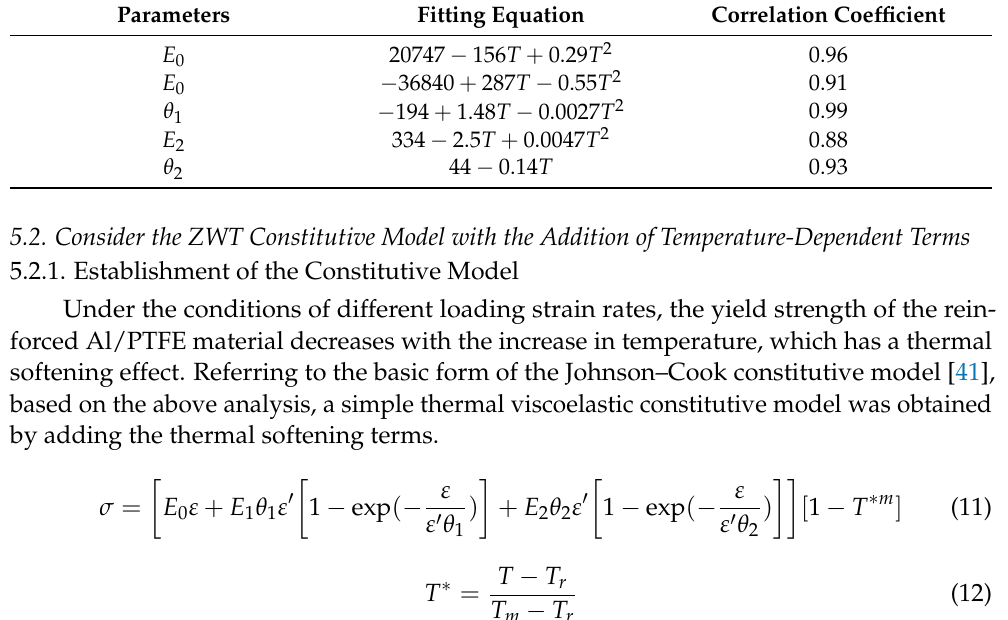
Table 6. The relationship between the parameters of the reinforced Al/PTFE constitutive model and temperature.